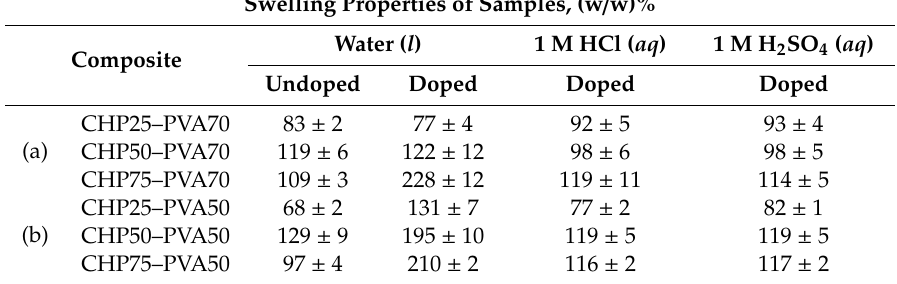
Table 1. Swelling tests of PVA / CHP 25–75 films: ( a ) with 70 wt.% content of PVA; ( b ) with 50 wt.% content of